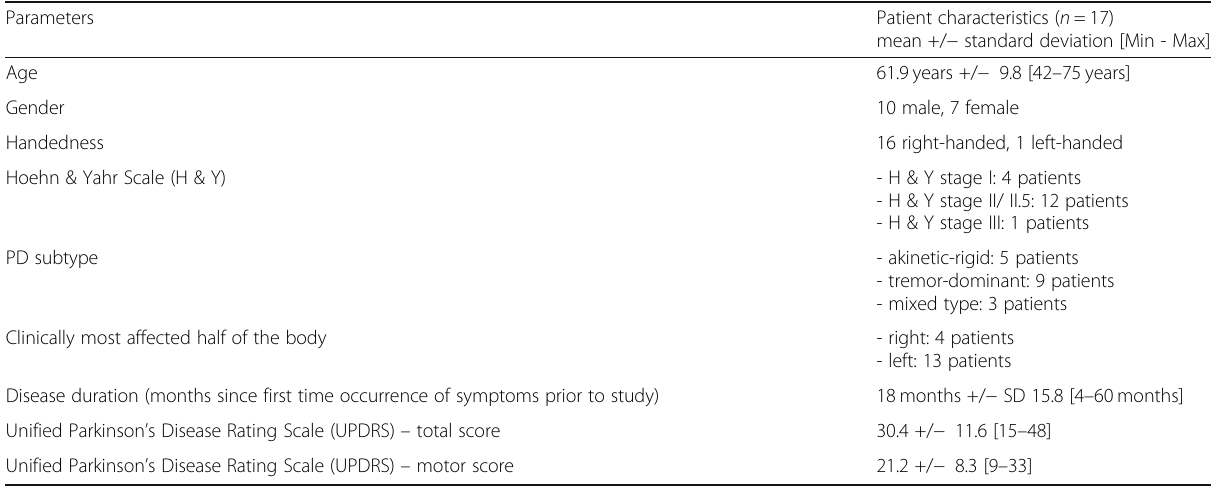
Table 1 Clinical characteristics of de novo Parkinson patients